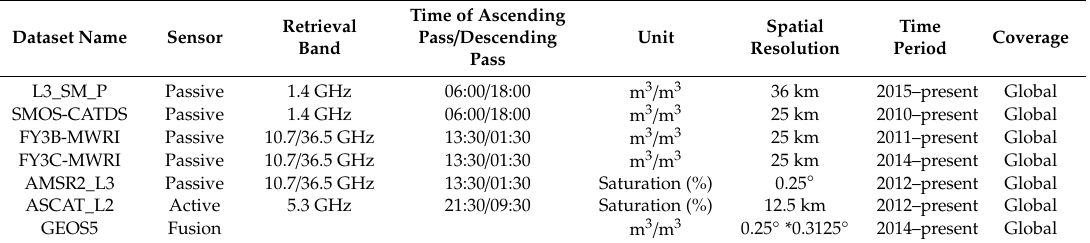
Table 1. Information of the satellites which were used to estimate global soil moisture in this